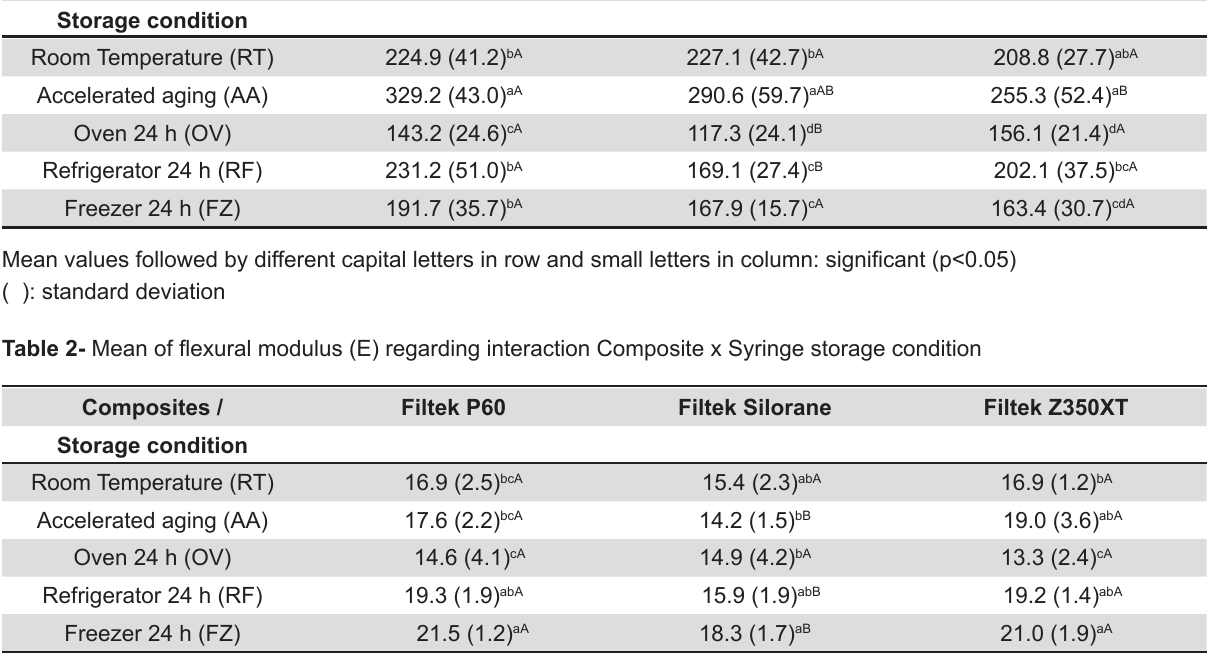
Mean values followed by different capital letters in row and small letters in column: significant (p<0.05) ( ): standard deviation